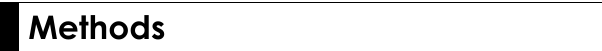
Table I. Frequency distribution of application for inpatient care (involuntary and assisted)